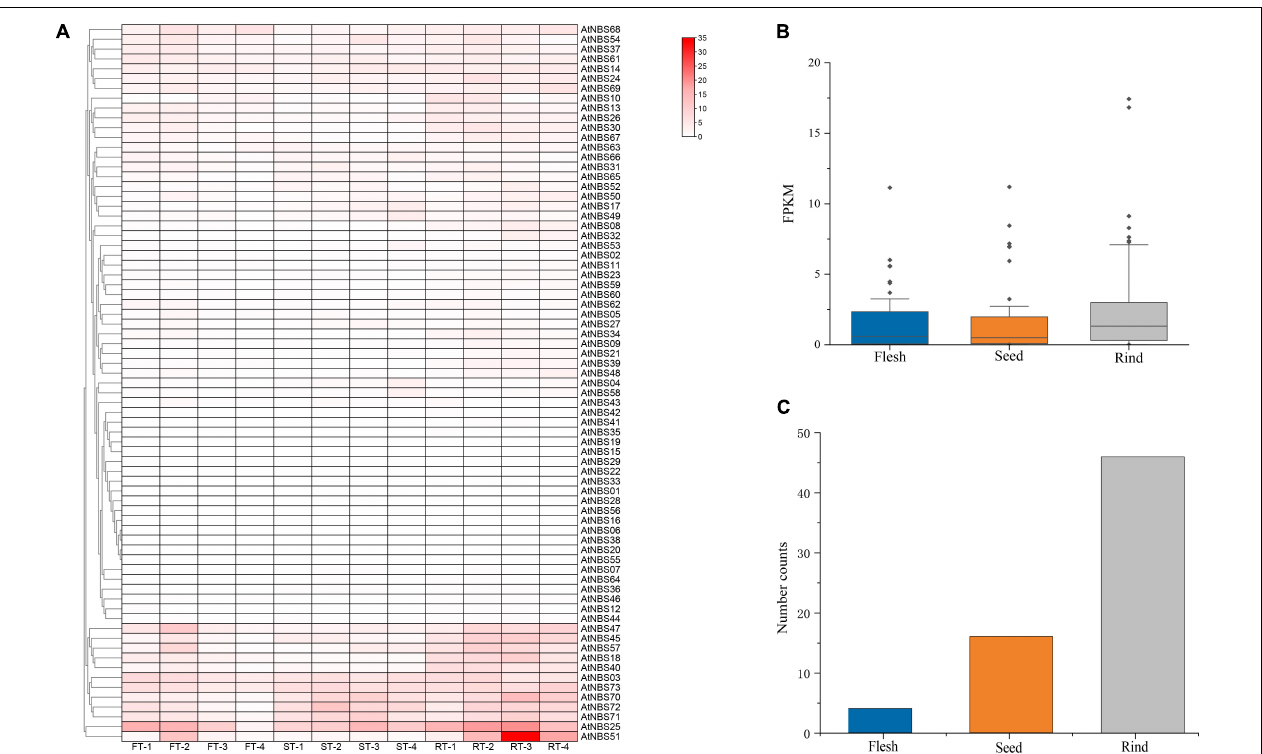
FIGURE 6 | Expression profile of A. trifoliata NBS genes. (A) Expression heat map of 73 NBS genes in three different fruit tissues at four developmental stages. (B) Mean expression of 73 NBS genes in the three tissues. (C) Quantitative distribution of the highest expression levels of NBS genes in